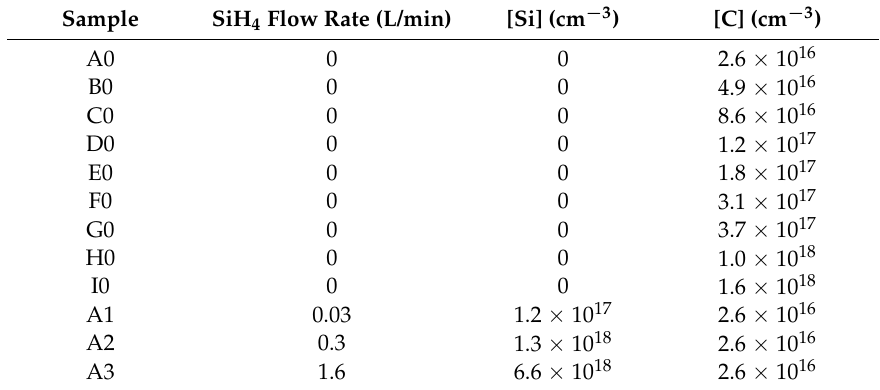
Table 1. Growth conditions of u-GaN and n-GaN samples, where [C] is residual C concentration, and [Si] is Si doping concentration.